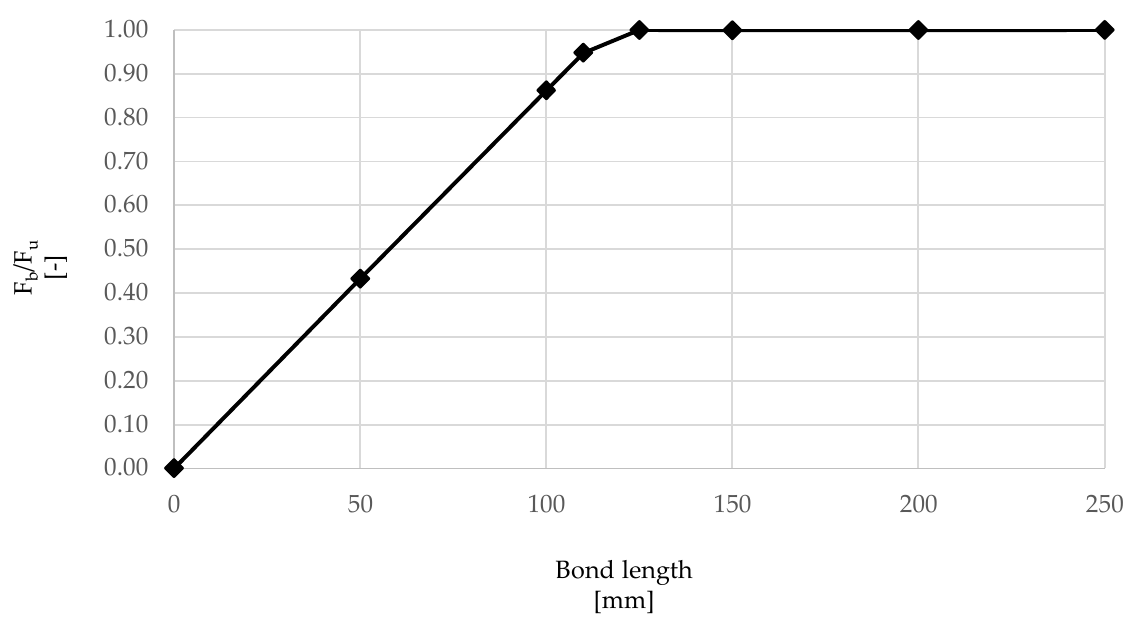
Figure 10. Variation of F b /F u with bond length.